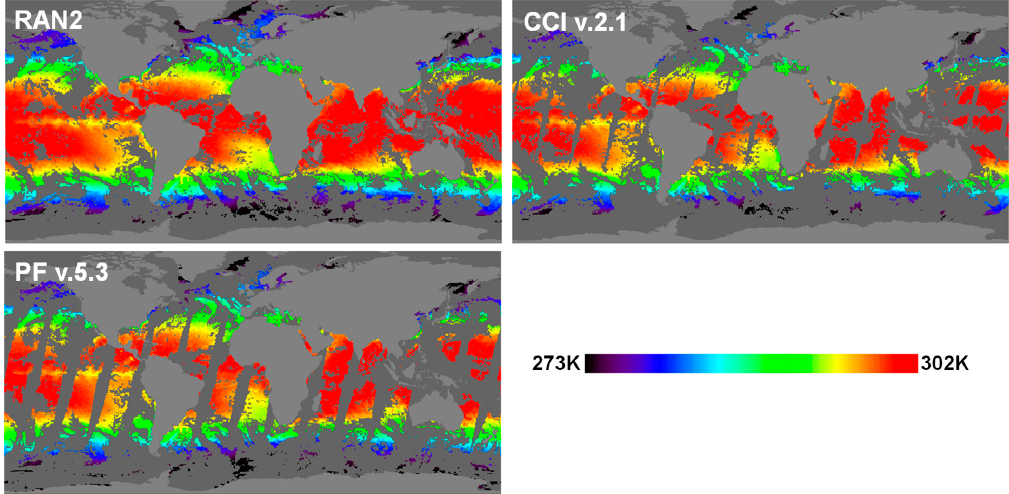
Figure 5. Global nighttime N18 L3C ‘subskin’ and ‘skin’ SSTs on 1 Jan 2009, produced from RAN2, CCI, and PF L3C. (Note that +0.17 K was added to CCI and PF ‘skin’ SSTs.) Land is rendered in lighter grey and ocean data with missing SST in darker grey.